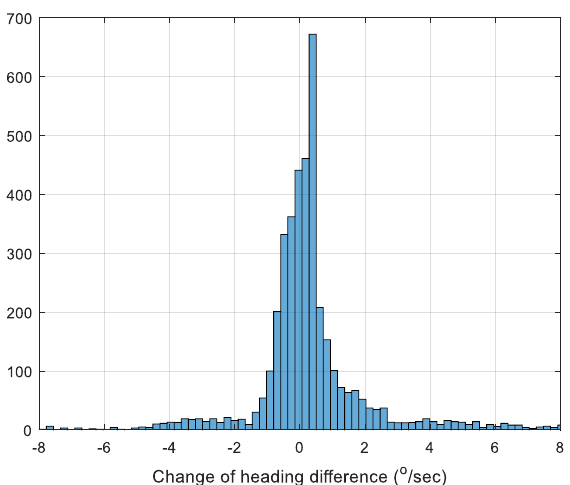
Figure 10. Histogram of the heading change difference between the fully-compensated method and